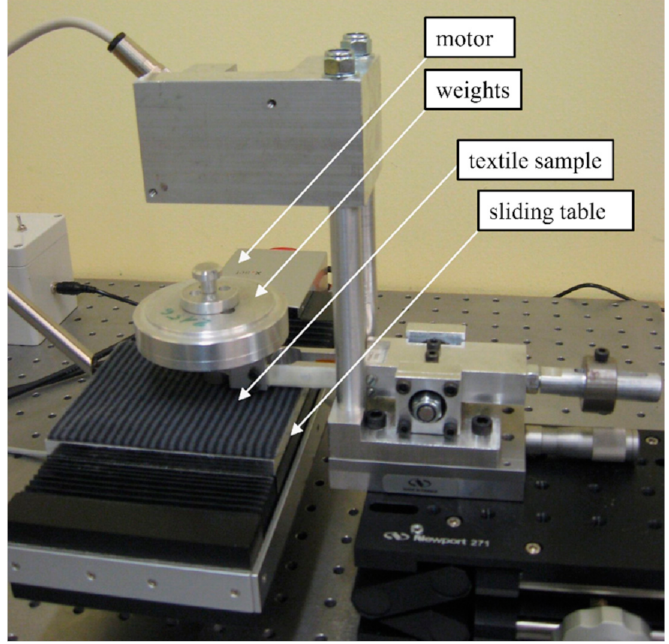
Figure 9. Custom-built reciprocating linear tribometer used to simulate friction between foot and sock [68]. Reproduced with permission from Baussan, E.; Bueno, M.A.; Rossi, R.M.; Derler, S., Experiments and modelling of skin-knitted fabric friction; published by Elsevier,